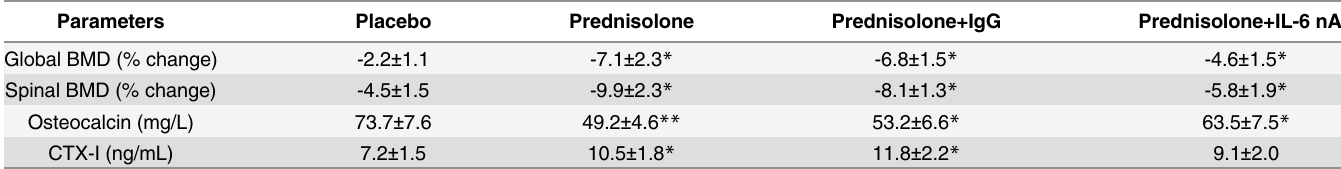
Table 3. BMD and serum biochemical measurements in osteoporotic mice with and without IL-6 nAb administration. Data shown are the mean ± SD. There are ten animals per group.